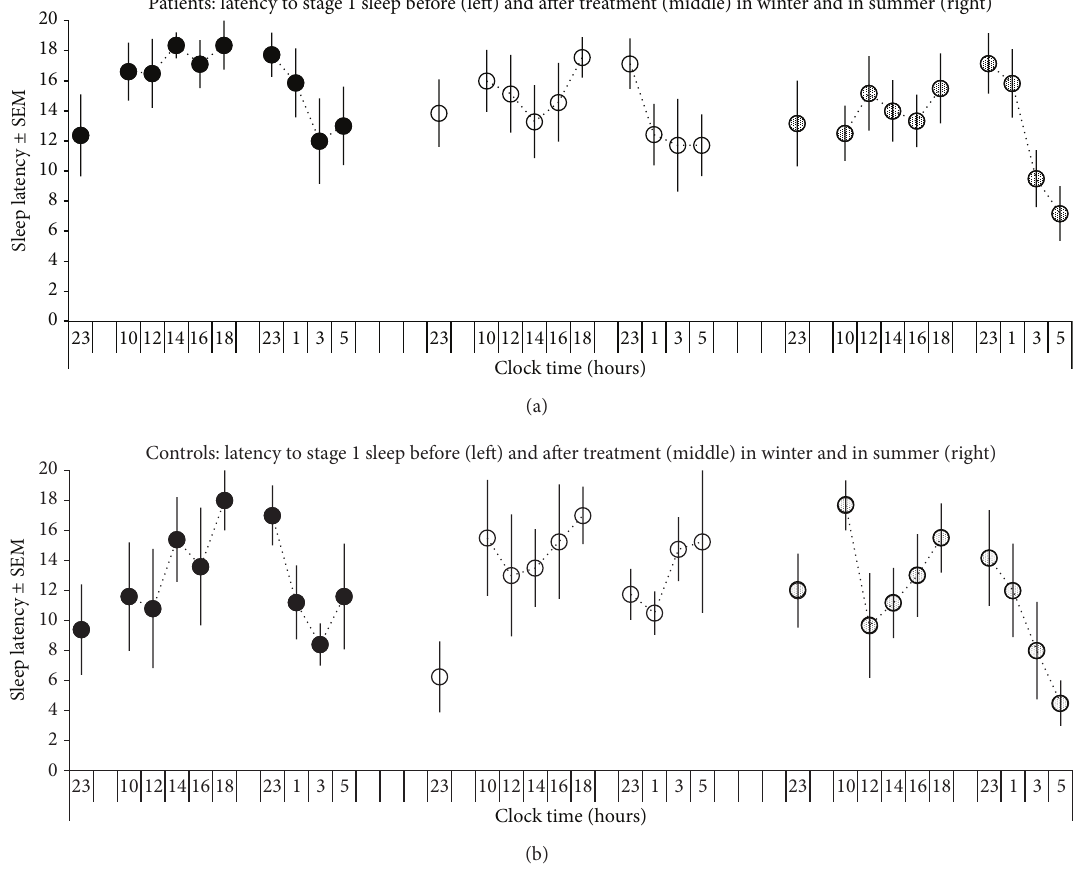
Figure 1: Time course of sleep latency in patients and controls. Sleep latency was tested 10 times on three occasions (in summer and in winter before and after treatment), during the first 20 min of baseline night sleep and during 5 daytime and 4 nighttime 20-min attempts to nap. See also notes to Table 1 and the results of comparison of patient and control groups in Table